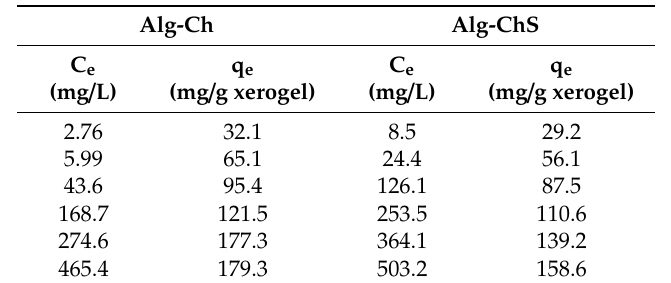
Table 1. Cu(II) adsorption onto Alg-Ch and Alg-ChS hydrogel beads at equilibrium at 25 ◦ C and initial pH = 5.0.